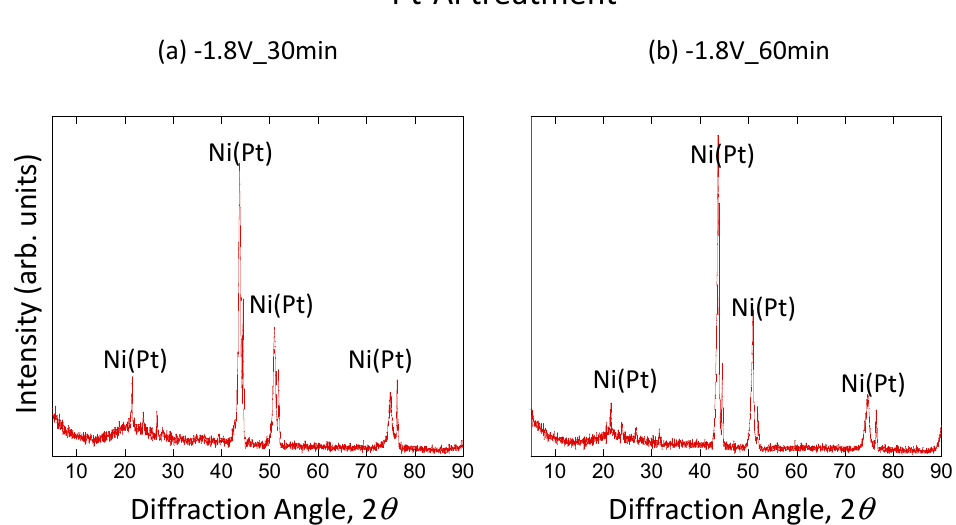
Figure 7. X-ray diffraction patterns for Pt-Al treatment ( a ) − 1.8 V for 30 min and ( b ) − 1.8 V for 60 min.